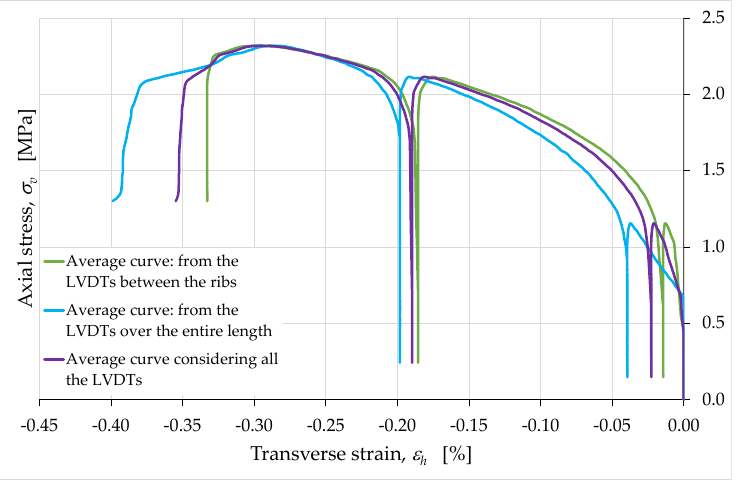
Figure 17. Average curves of axial stress with respect to transverse strain, obtained from the relative displacements over the inter-rib length and over the entire length of the long side faces.